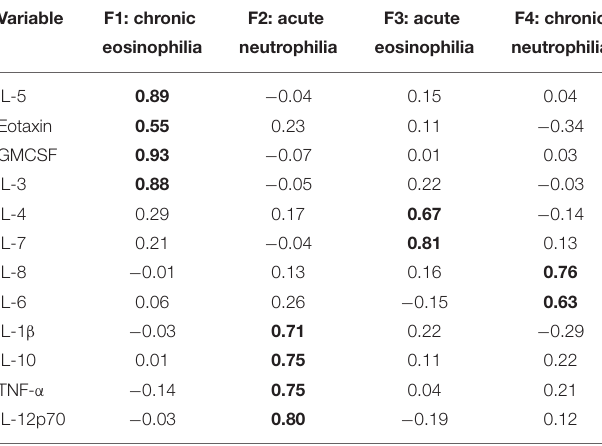
dental healthcare workers.